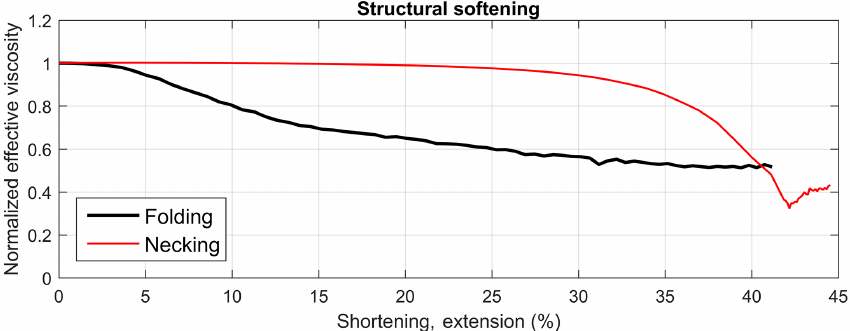
Figure 18. Structural softening during folding (black line) and necking (red line) of the simulations shown in Fig. 4. The effective viscosity is calculated by the ratio of the area-averaged square root of the second invariant of the deviatoric stress tensor, σ II , to the absolute value of the bulk rate of deformation, ¯ D xx , which was constant during the simulations. The effective viscosities are divided by the initial value of the effective viscosity and are plotted vs. the bulk shortening for folding and the bulk extension for necking. Structural softening starts earlier for folding than for necking but the structural softening for necking is more